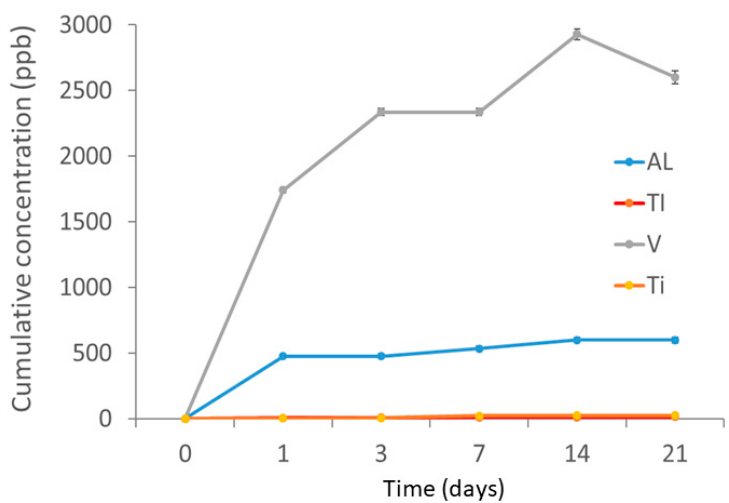
Figure 6. Cumulative concentration of release of titanium, aluminium and vanadium ions. The release of titanium ions from commercially pure Ti grade 4 and Ti–6Al–4V alloy implants overlap. The values are very similar and very low (<30 ppb in both material